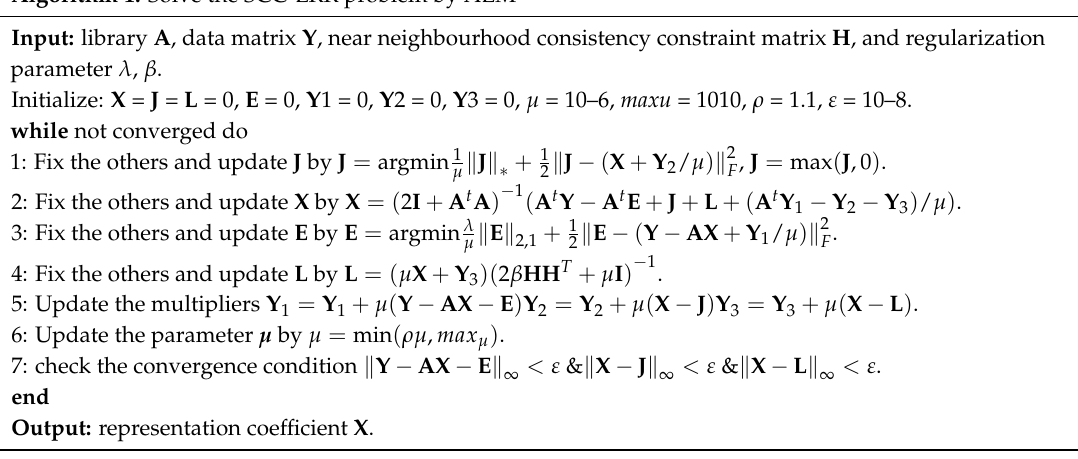
Algorithm 1: Solve the SCC-LRR problem by